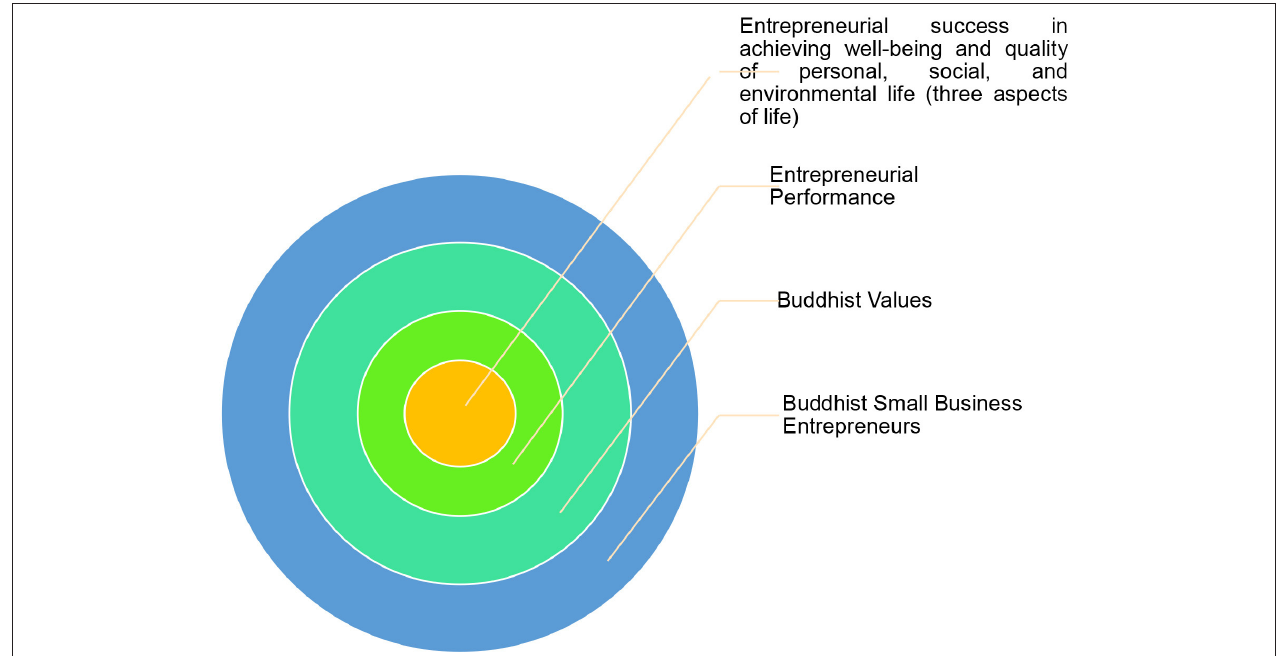
FIGURE 1 | The role of Buddhism in entrepreneurial performance. Source: Lufina Mahadewi.